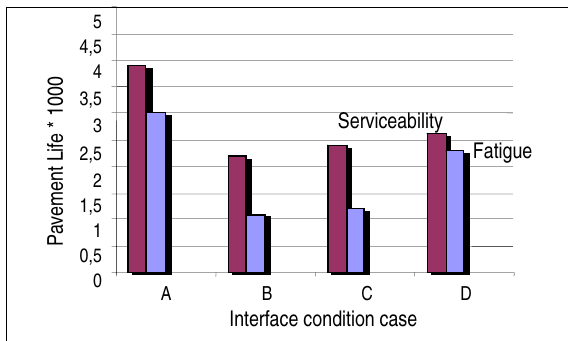
Fig 2 . Fatigue and serviceability lifes for different cases of intrface